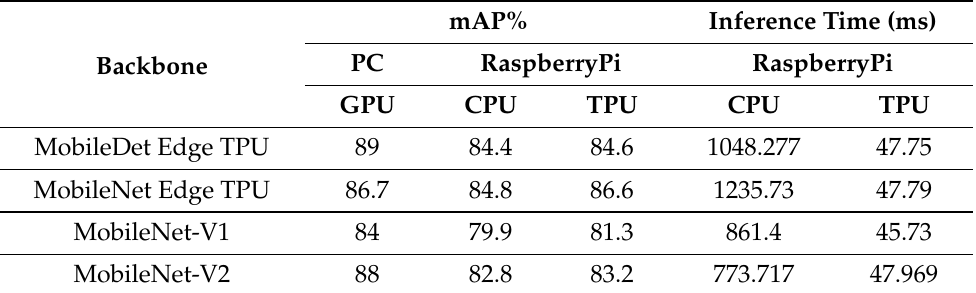
Table 2. Performance of the models in terms of accuracy and inference time (ms).